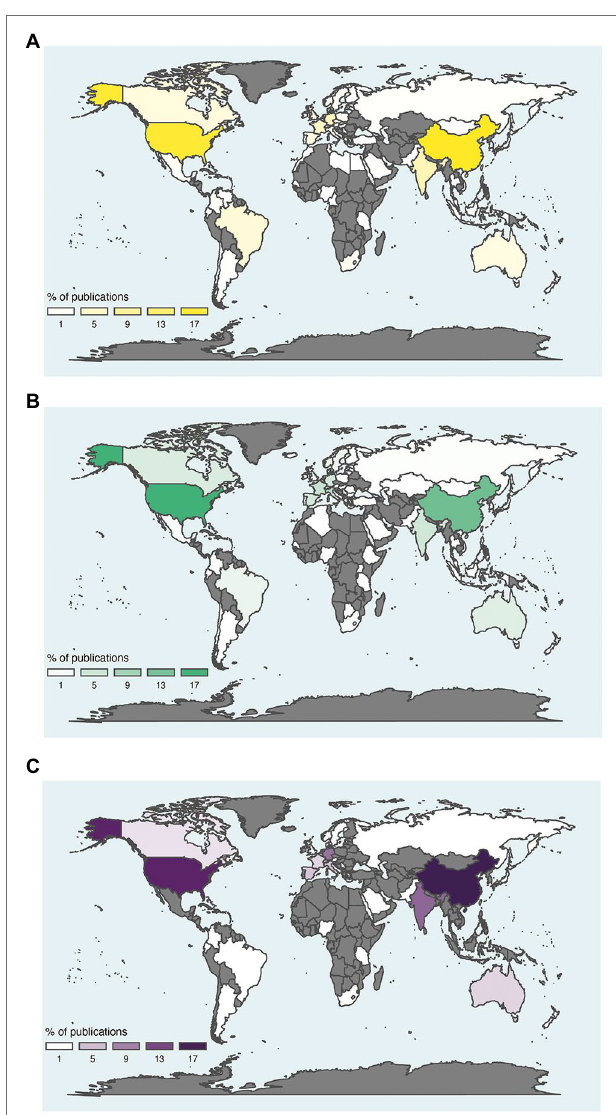
FIGURE 5 | Distribution of publications on meta-omics approaches in relation to soil (A) , food (B) and soil and food (C) . World distribution of publications on soil (A) , food (B) and soil and food (C) using meta-omics approaches. This analysis relies on keywords present in the title or abstract, related to meta-omics (merging studies on metabarcoding, metagenomics, metatranscriptomics and meta-proteomics) and based on the country of the first author. Gray areas, absence of publication.